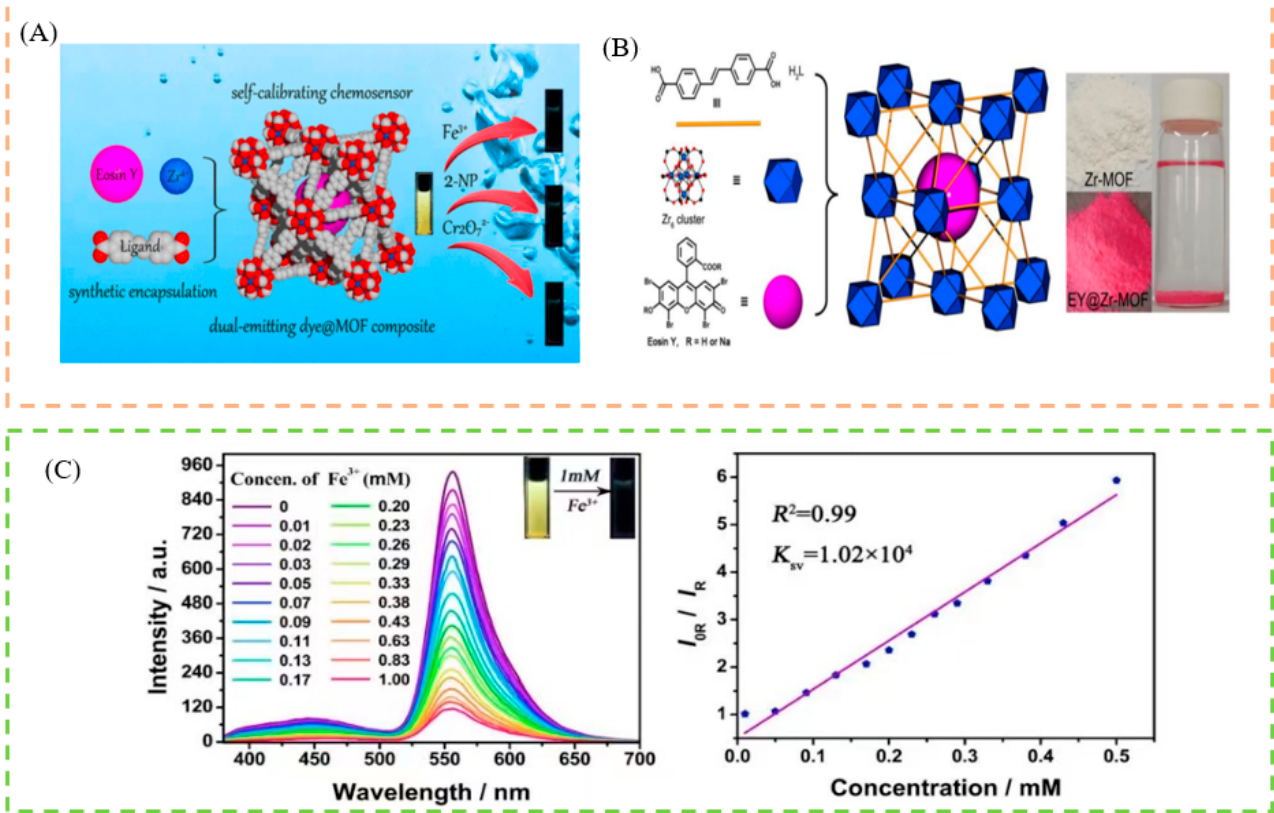
Figure 6. ( A ) Schematic illustration of the detection of Fe 3+ , Cr 2 O 72 − , and 2-nitrophenol, by the lumi- nescent sensor. ( B ) Schematic illustration of fabrication of the EY@Zr-MOF composite via the in situ synthetic encapsulation method. ( C ) Schematic illustration of the concentration-dependent fluores- cent emission spectra upon the different contents of Fe 3+ in aqueous solutions. Reproduced with permission from [137]. Copyright 2019, American Chemical Society.